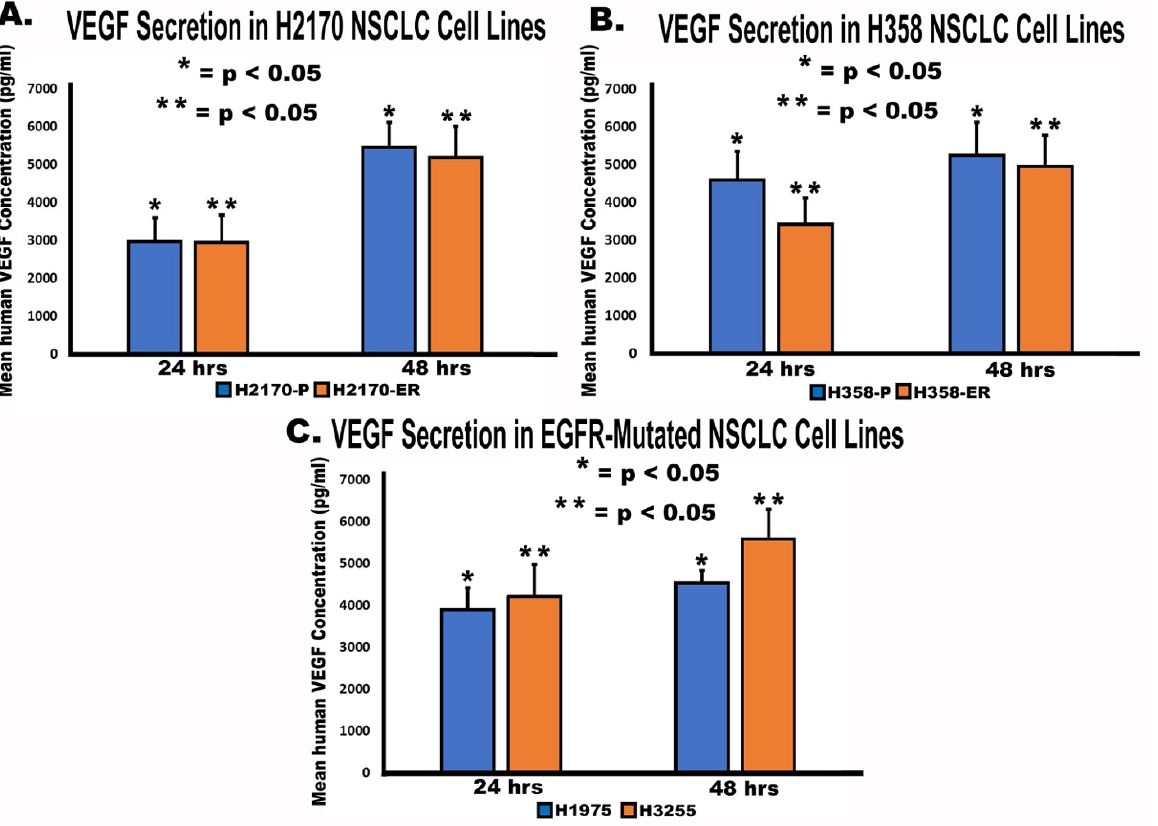
Figure 5. Secretion of VEGF in NSCLC cell lines. For the analysis 3.75 × 10 6 H2170-P/ER, H358- P/ER, H1975, and H3255 cells were plated in vented flasks and allowed to adhere for 24 h in RPMI medium with 10% FBS. After 24 h, medium was removed, followed by PBS washes, and then starving medium (RPMI + 0.5% BSA) was added and incubated for 24 h. The medium was then centrifuged, and the pellets were stored in − 70 °C. Collection of conditioned medium was repeated for 24 h and 48 h time points. The amount of VEGF in ( A ) H2170-P/ER, ( B ) H358-P/ER, and ( C ) H1975 and H3255 NSCLC cell lines was quantified at two time points, 24 and 48 h, and the experiments were run in triplicate. Statistical analysis was performed, and the results were found to be statistically significant (* = p < 0.05) by way of a two-tailed t -test analysis. One asterisk (*) denotes statistical significance